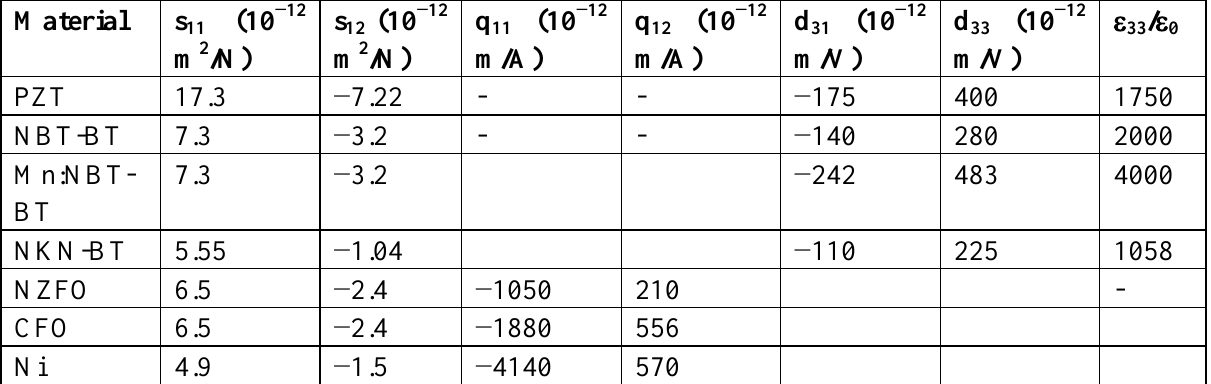
Table 5. Material parameters (compliance coefficient s, piezomagnetic coupling q, piezoelectric coefficient d, and permittivity ε) for NZFO, CFO, Ni, PZT and lead-free ferroelectrics [161,162] used for theoretical estimates.